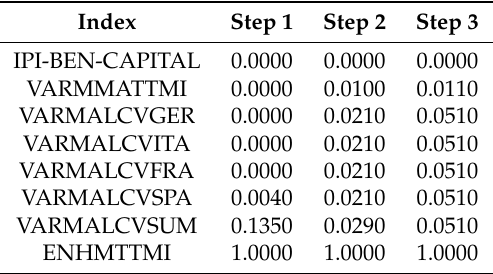
Table A27. Model confidence set hierarchy loss function is absolute error at the end of the sample for capital goods model comparison α = 0.05, number of bootstrap replications = 5000, and block length = 12. The null hypothesis is that the average performance of the model in the row is as small as the minimum average performance across the remaining models. The alternative is that the minimum average loss across the remaining models is smaller than the average performance of the model in the row.